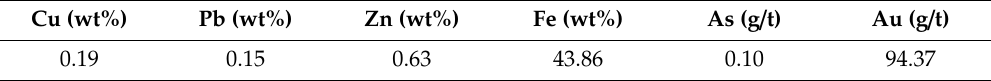
Table 1. Chemical composition of the complex sulfide concentrate.